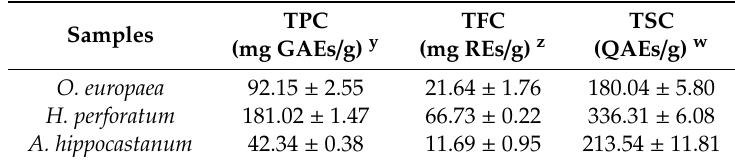
Table 1. Total phenolic, flavonoid, and saponin contents of the water extracts from plants.